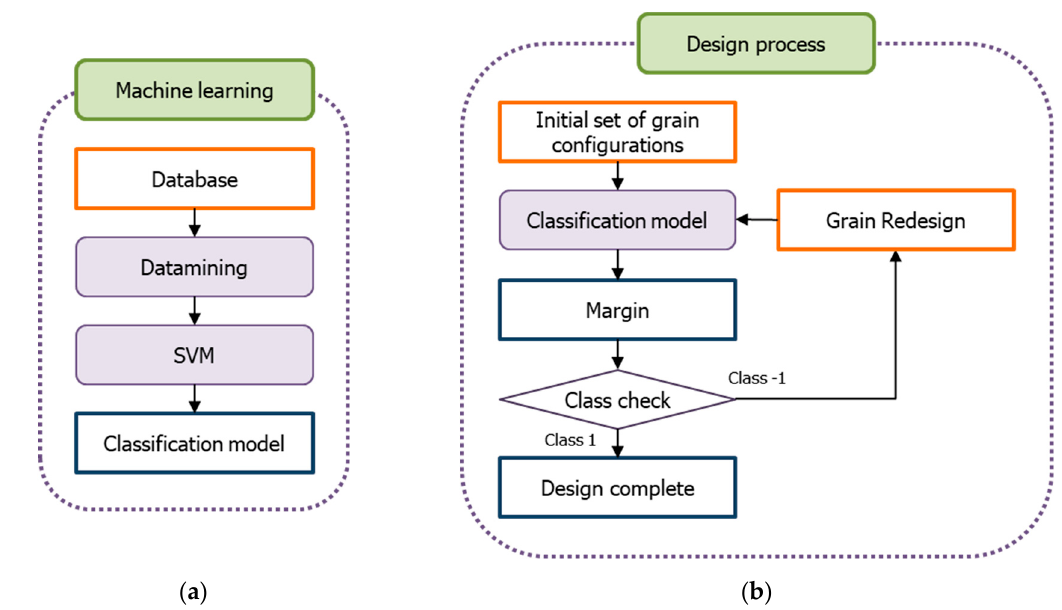
Figure 3. Grain design process applying machine learning ( a ) machine learning ( b ) design using model.